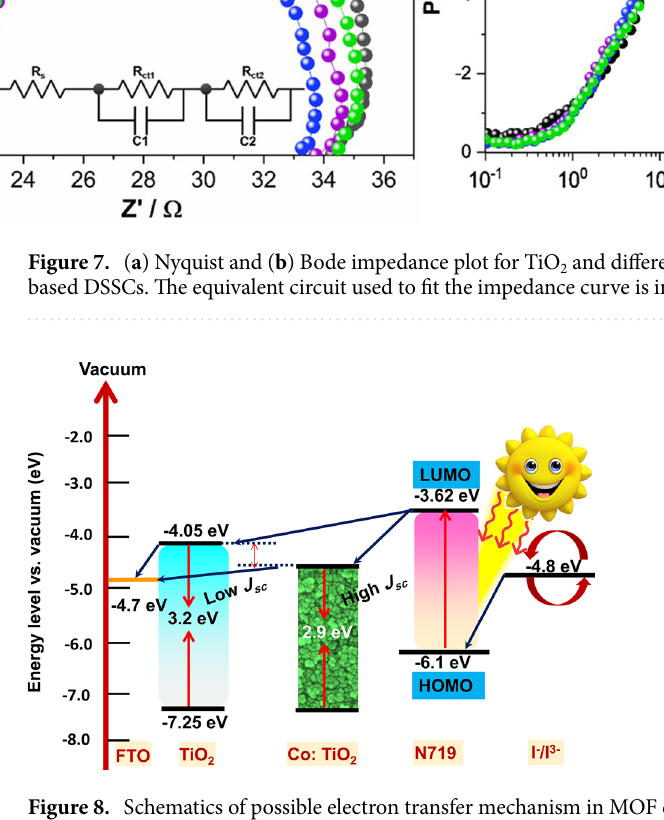
Figure 8. Schematics of possible electron transfer mechanism in MOF derived Co 2+ ion doped TiO 2 photoanode based